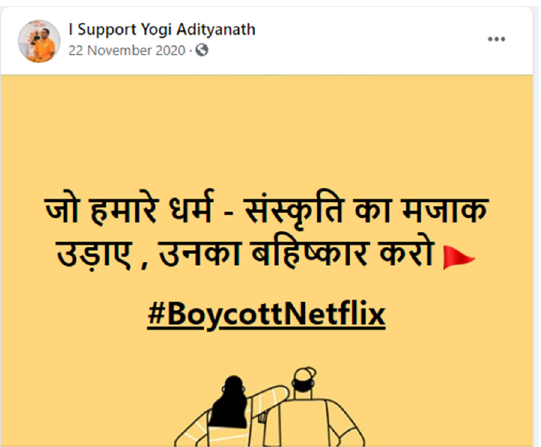
Figure 15. Facebook post #BoycottNetflix “boycott those who joke about Hindu religion and culture”.